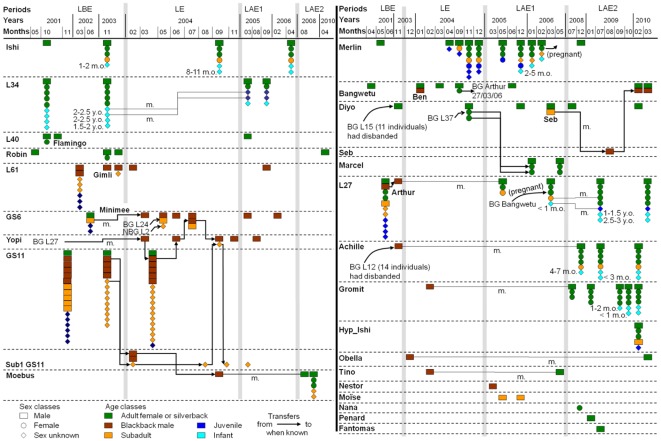
Dynamics of the units during the study period (2001–2010).Only the units observed after the Ebola outbreak are included. The unit compositions are given at the first visit on the clearing, for every change in composition, and at the last visit. Only the months and years when any change in a unit composition occurred are mentioned. The names of units or individuals are in bold. BG: Breeding group; NBG: non-breeding group. m.: maturation of an individual during the period indicated by a line. m.o. (months old) or y.o. (years old): estimates of the age of infants at the date of observation. The grey bars distinguish between the study periods. LBE: Lokoué pre-Ebola period: April 2001 to November 2003, LE: Lokoué during Ebola period: December 2003 to December 2004, LAE1: Lokoué post-Ebola period 1: December 2004 to May 2006 and LAE2: Lokoué post-Ebola period 2: June 2008 to April 2010.